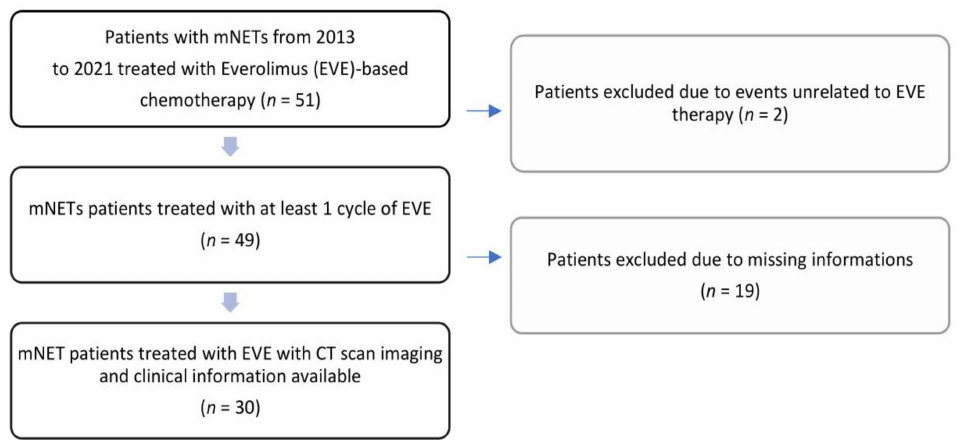
Figure 2. Flow diagram of patients identified and included in the final analysis. NET, neuroendocrine tumor; EVE, everolimus; CT, computed